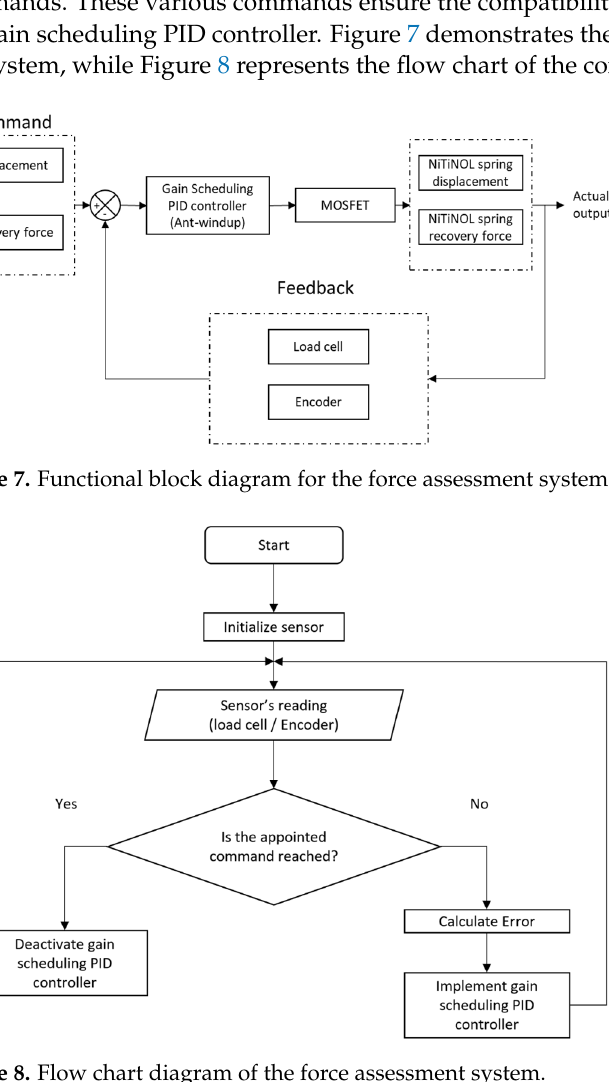
Figure 8. Flow chart diagram of the force assessment system.